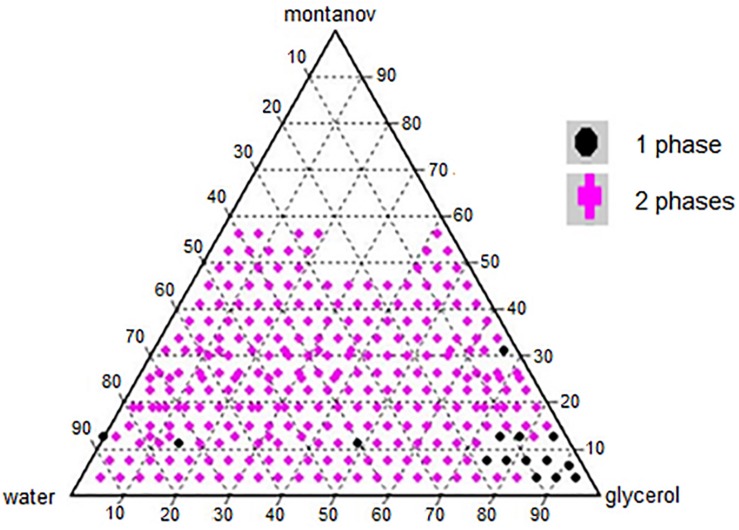
Ternary compositions of surfactant, co-solvent (glycerol), and double distilled water.